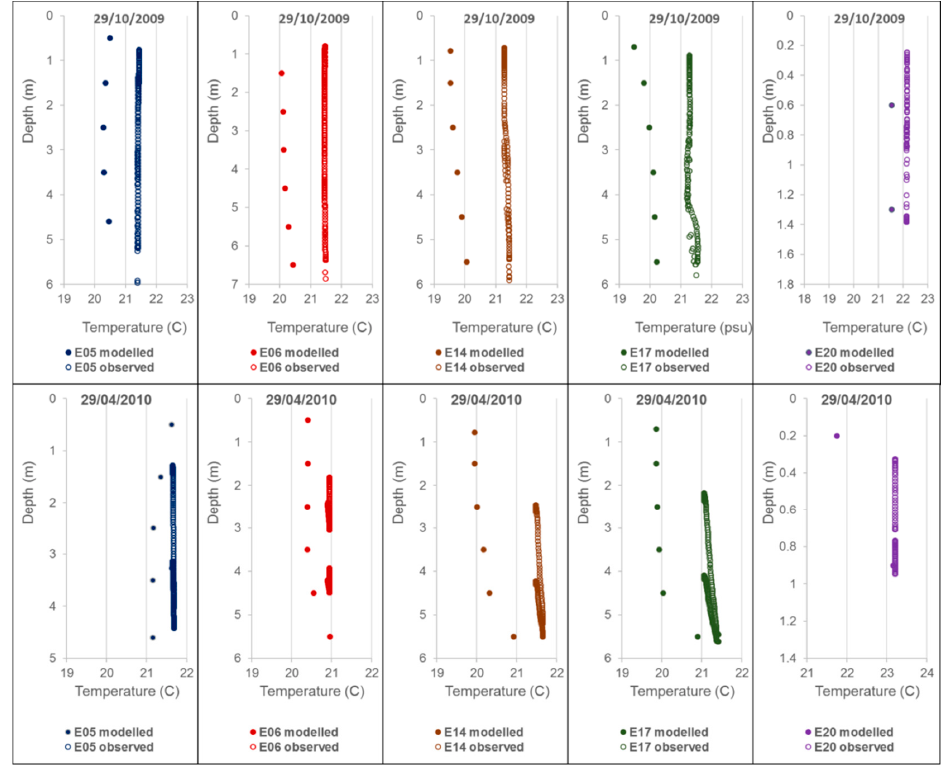
Figure 4. Modelled and observed vertical profiles of temperature on 29 October 2009 and 29 April 2010.